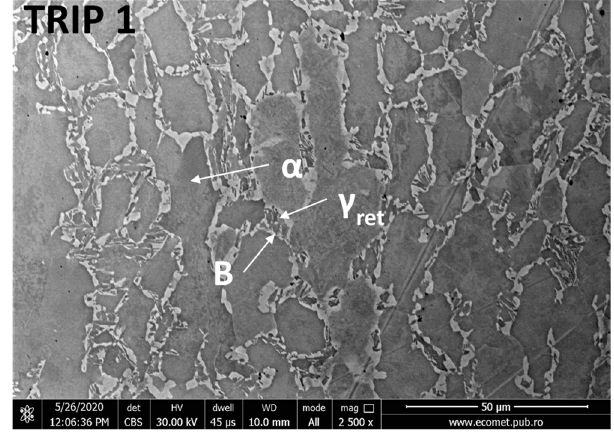
Figure 1. BSE microstructure of TRIP 1 steel after heat treatment.